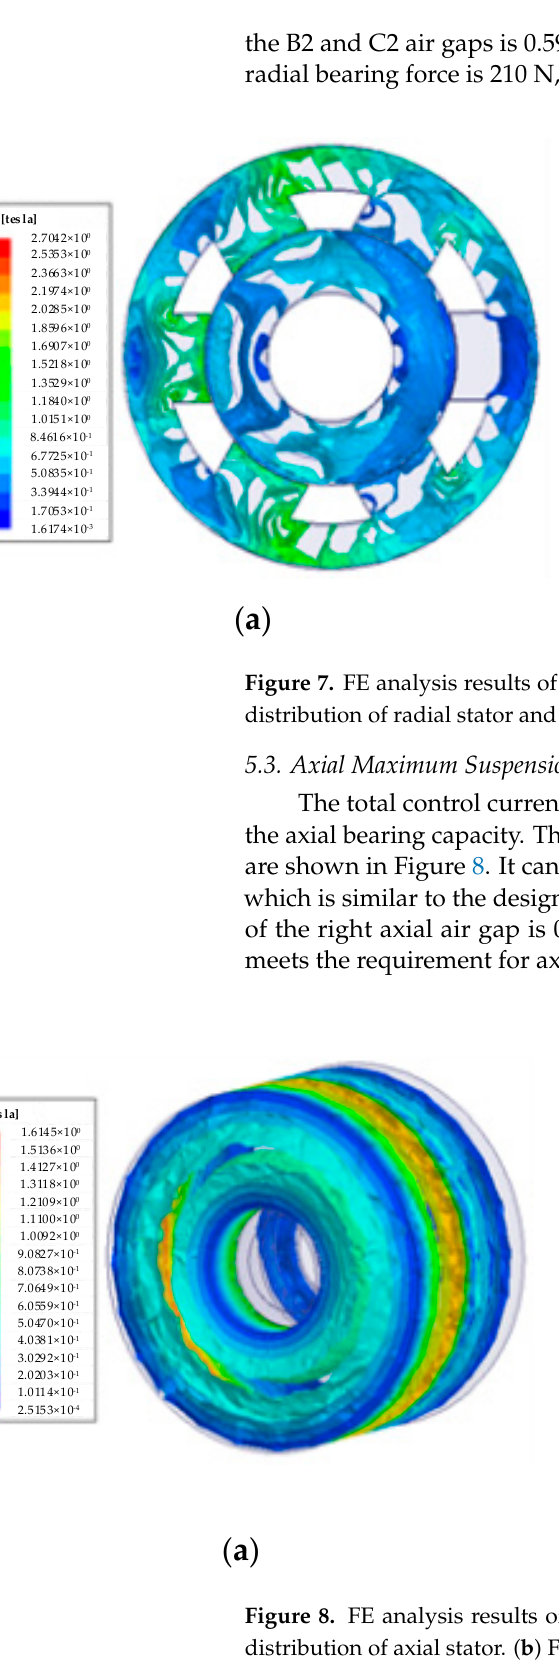
( d ) Figure 6. FE analysis results of radial and axial biased flux density. ( a ) Flux distribution of radial stator and rotor. ( b ) Flux distribution of axial stator. ( c ) Flux density in radial air gaps. ( d ) Flux density in axial air gaps. 5.2. Radial Maximum Suspension Force Analysis As the maximum current in radial control coils is 160 A, the control current of the A-